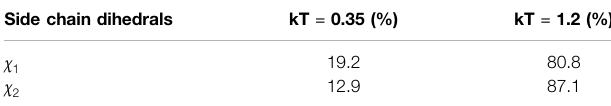
TABLE 1 | Percentage of amino acids per backrub con fi guration ( kT (cid:1) 0 . 35 and kT (cid:1) 1 . 2) for each side chain dihedral that sampled the conformational space similarly to MD simulations among all the 10 MHC class II crystal structures Side chain